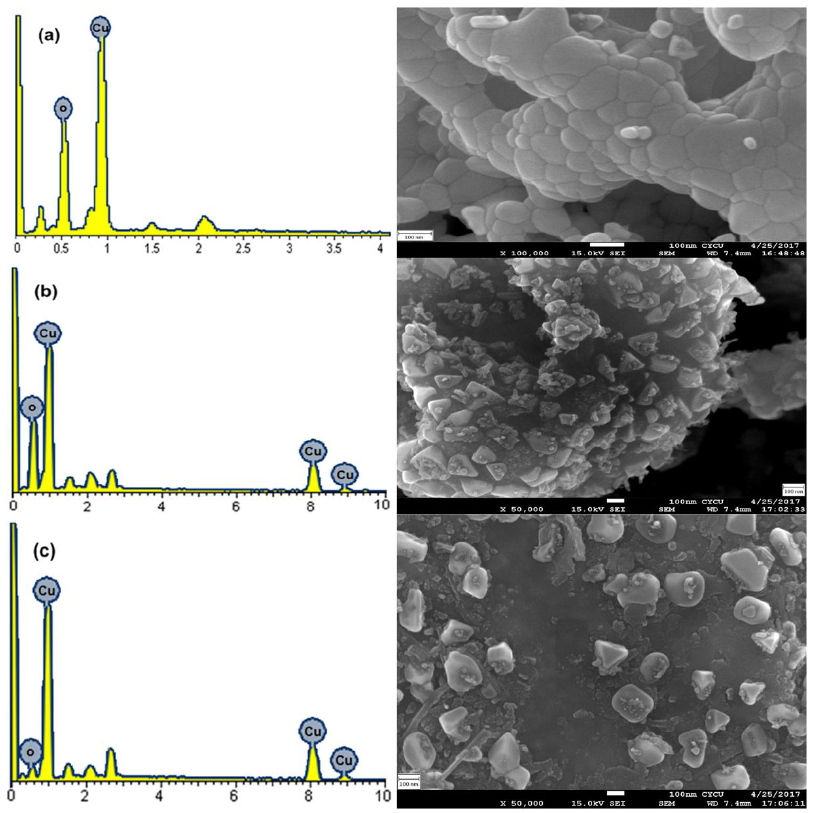
Figure 2. SEM with EDS images of prepared Cu-based nanoparticles at various G/N ratios: G/N = 0.3 ( a ), G/N = 0.5 ( b ), and G/N = 0.7 ( c ).